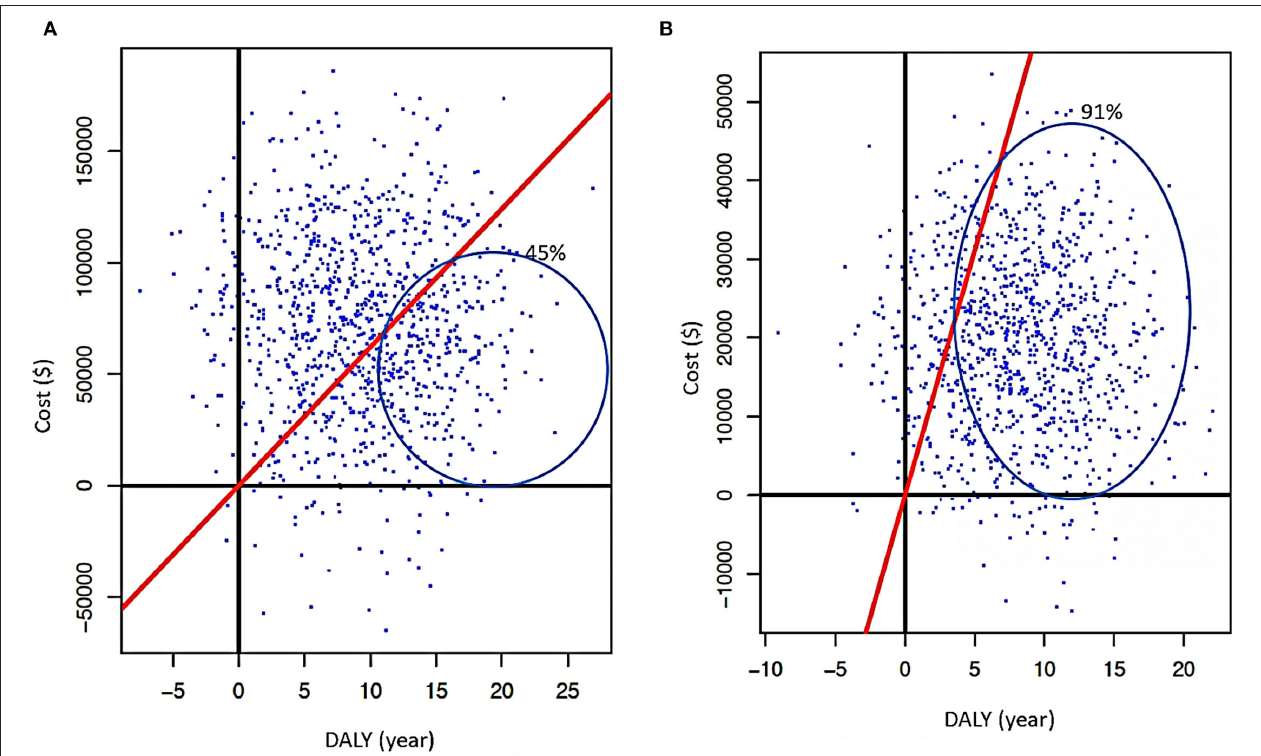
FIGURE 5 | (A) Cartesian plane representing PSA when PrEP is used without other intervention is applied with deterministic data. (B) Results of PSA when PrEP is used (at high-risk populations) using stochastic data (red continuous line represents GDP’s threshold; cost is in American dollars and DALYs in